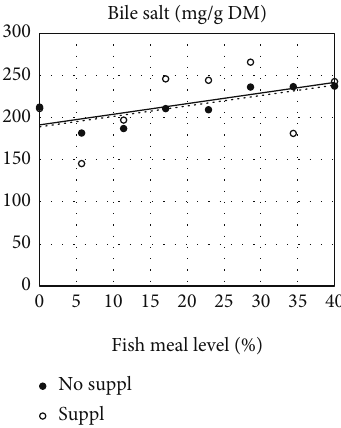
Figure 6: E ff ects of increasing fi shmeal level on trypsin activity in chyme from the two halves of the pyloric intestine (PI1 and PI2) in fi sh fed diet series with the mixture of supplements, i.e. 0.3% choline chloride, 0.05% β -glucan, and 0.05% nucleotides. For both sections, the regression model was highly signi fi cant. For the fi sh fed the unsupplemented diet series, there was no signi fi cant e ff ect of fi shmeal level. For statistics, see Table